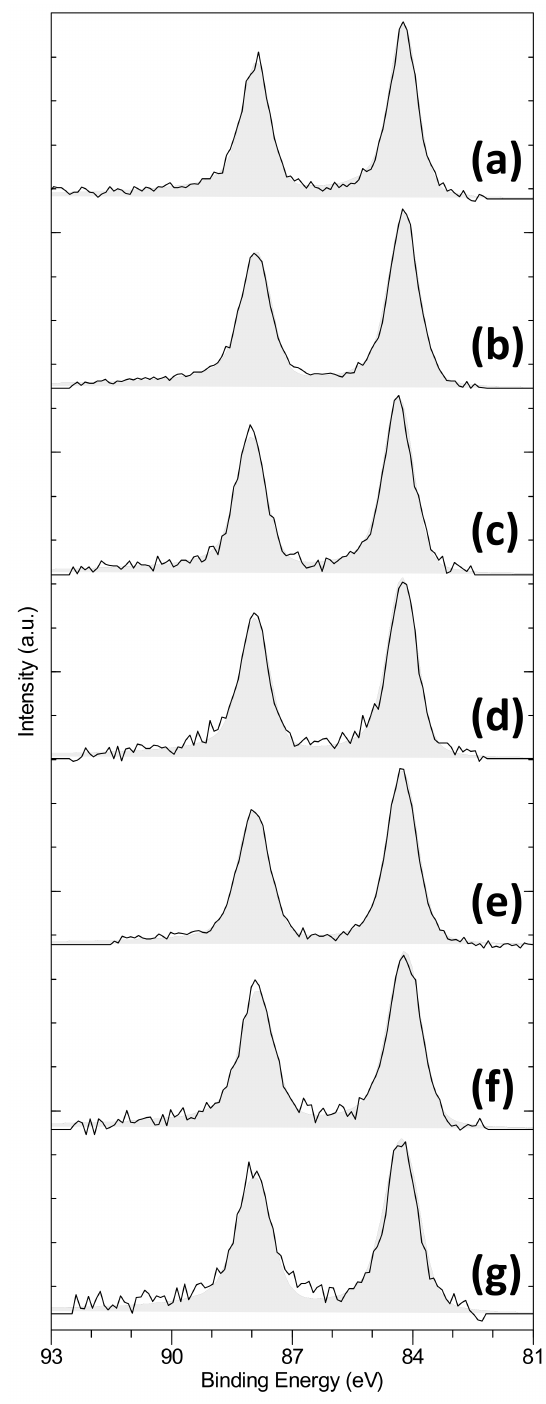
Figure 4. XPS high resolution spectra corresponding to Au 4f for samples listed in Table 3: ( a ) 0.86%AuCZ; ( b ) 4.3AuPd-O; ( c ) 3.7AuPd-O; ( d ) 1.8AuPd-O; ( e ) 1.4AuPd-O; ( f ) 0.6AuPd-O; and ( g )